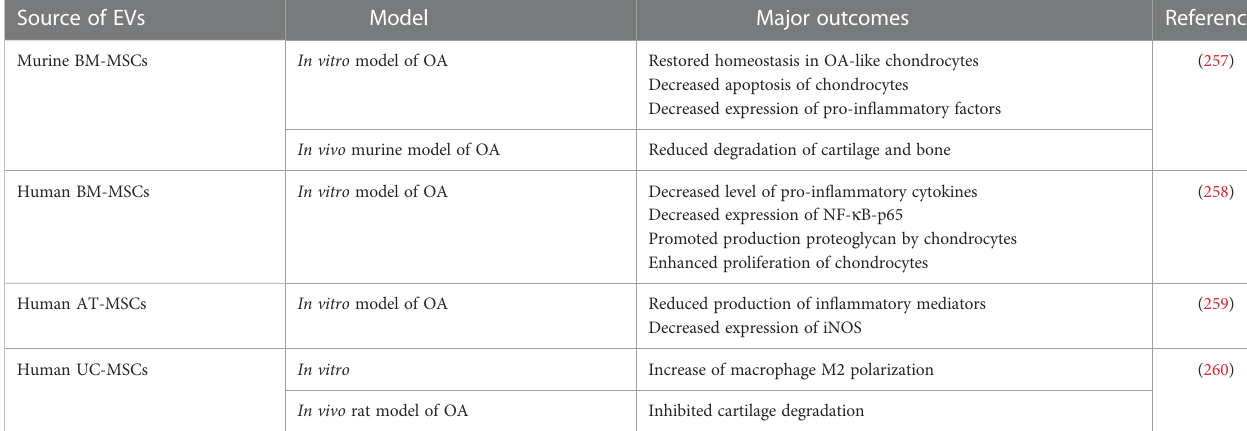
TABLE 10 Examples of EV use in preclinical studies related to the treatment of